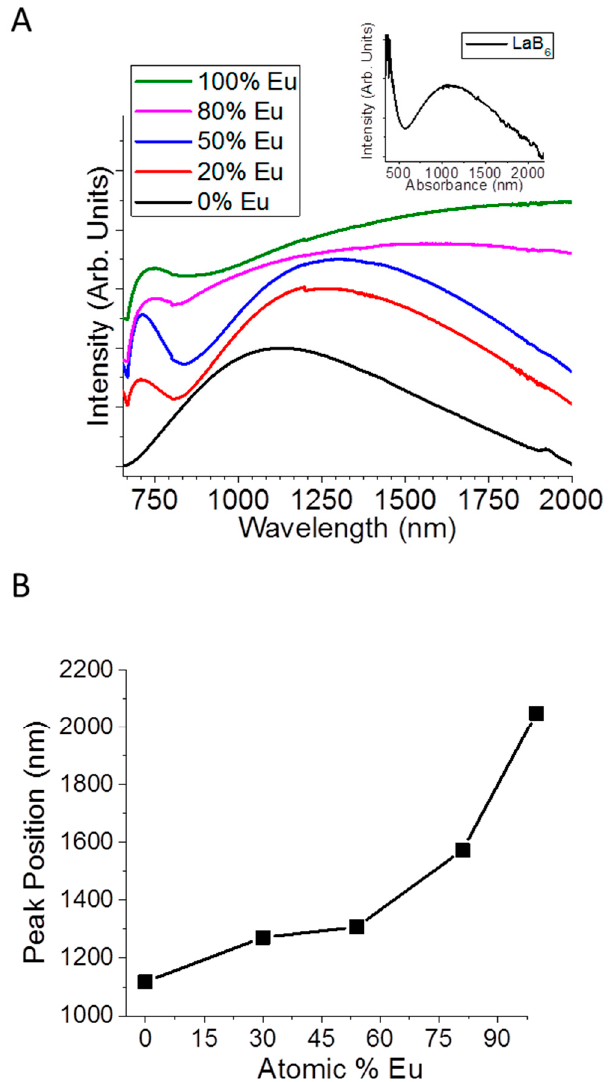
Figure 3. ( A ) Absorbance of La x Eu 1 − x B 6 changing with Eu content (normalized) and ( B ) absorbance peak position versus atomic % Eu in La x Eu 1 − x B 6 .